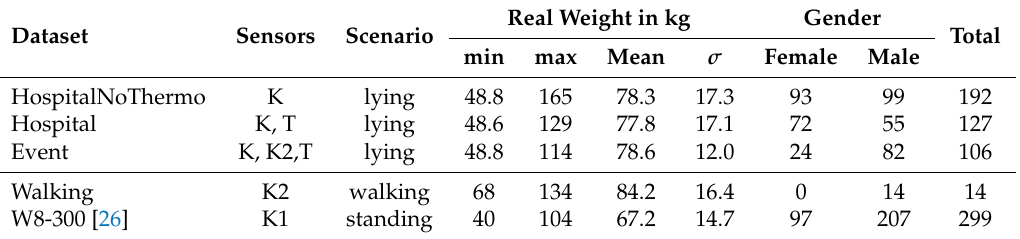
Table 6. Datasets applied for this article: The first two datasets are recorded in a trauma room of the University Hospital Erlangen, Germany. The third dataset is based on a public event in a laboratory, containing visitors of this event. The fourth set is recorded with employees and students of the laboratory. For comparison, the average body weight of the German population in 2009 is 73.9 kg [45]. This average value is close to the first three datasets. The last dataset W8-300 is recorded by [26], showing people standing in the front of a Kinect